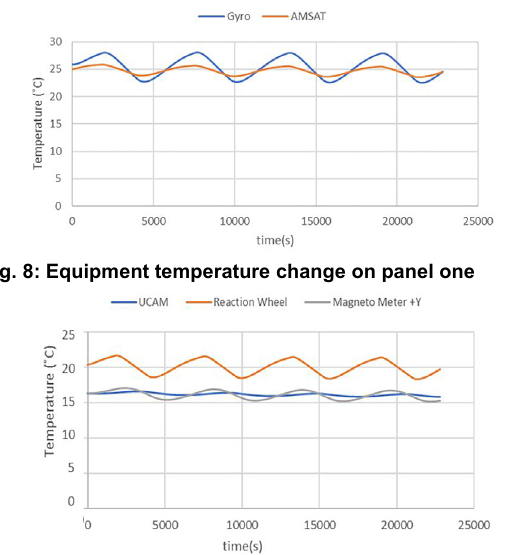
Fig. 5 External heat fluxes on structural panel +Y as predicted by ESATAN and Thermal Desktop (node 50).